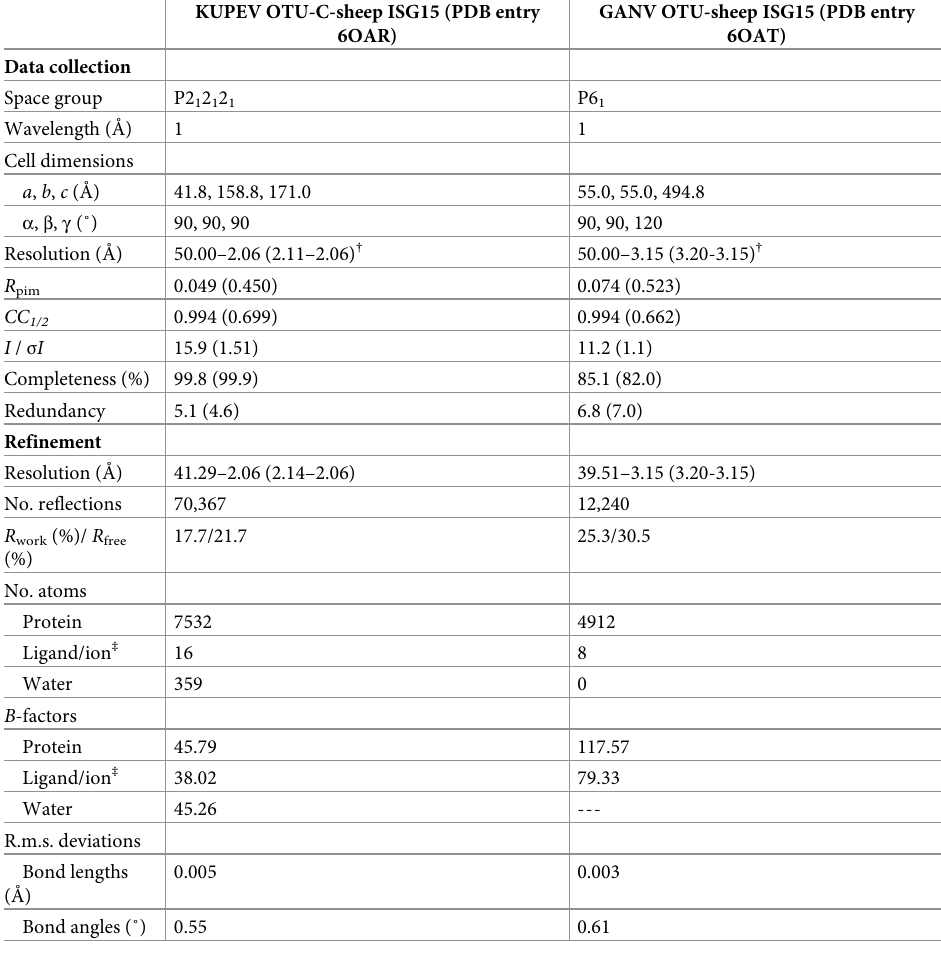
Table 1. Data collection and refinement